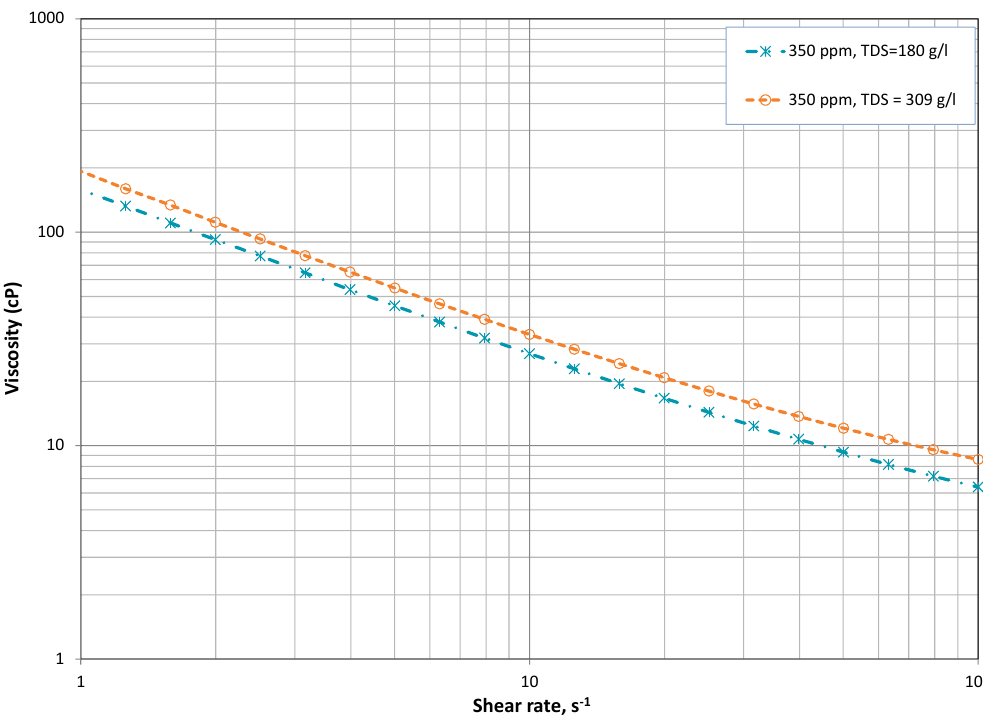
Figure 3. Salinity effect on the measured biopolymer solution viscosity. Total dissolved solids (TDS).